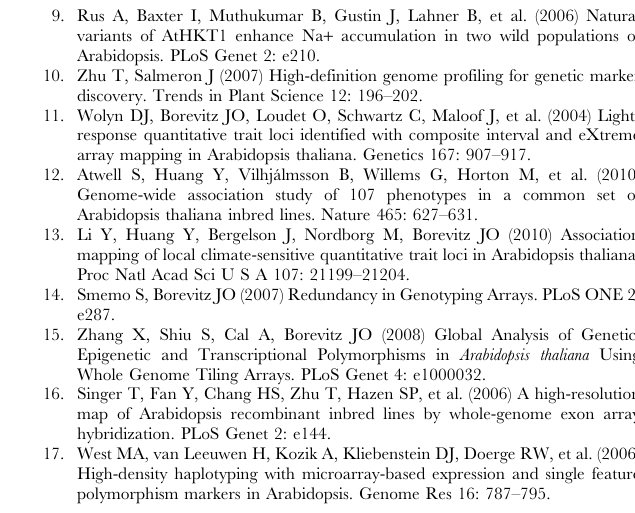
Figure S6 Ler-1, antisense probe distributions. (Top) Histograms of the antisense probe-wise difference in allele signals between the Col-0 and Ler-1 parent arrays for probe sets marked by the Atwell et al. [12] as polymorphic (markers) and not marked as polymorphic (controls). (Bottom) Histograms of the allele signals from the parent arrays and the pseudo-F 1 array constructed from the mean of the parent arrays. Figure S7 Ler-1, sense probe distributions. (Top) Histo- grams of the sense probe-wise difference in allele signals between the Col-0 and Ler-1 parent arrays for probe sets marked by the Atwell et al. [12] as polymorphic (markers) and not marked as polymorphic (controls). (Bottom) Histograms of the allele signals from the parent arrays and the pseudo-F 1 array constructed from the mean of the parent arrays. (PDF) File S1 BSA using SNPs supplies script. R script containing the functions necessary to perform BSA using the ATSNPTILE1 array. This script supplies information for File S2. This is not the script to open in order to perform BSA using the ATPSNPTILE1 array, but is needed for the process. File S2 BSA using SNPs script. R script that contains first instructions and relies on the information in File S1 to perform our